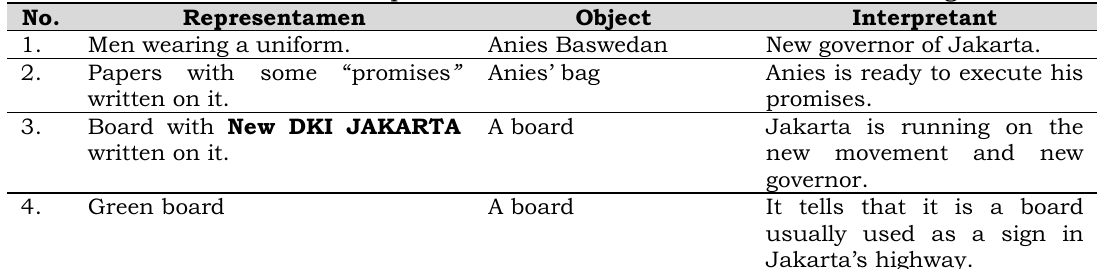
Classification of first political cartoon based on Pierce’s model of